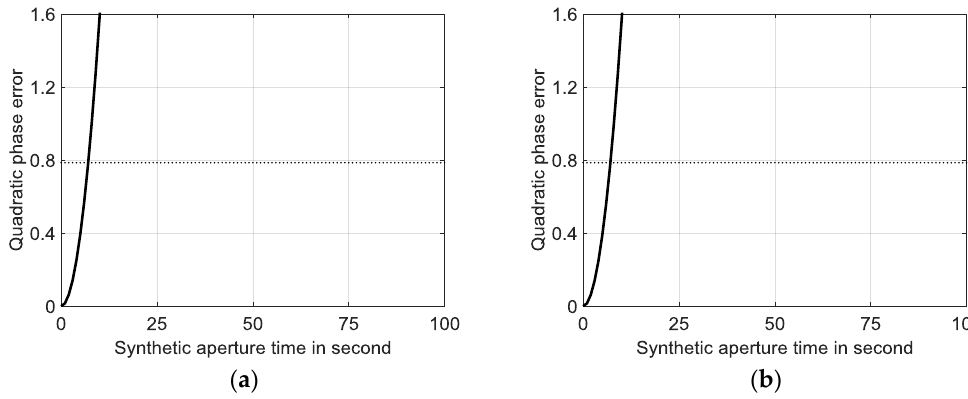
Figure 7. Quadratic phase error caused by the lunar revolution within an exposure time of 100 s: ( a ) a g 0 − a m = 0 ( b ) a g 0 − a m = π /6.